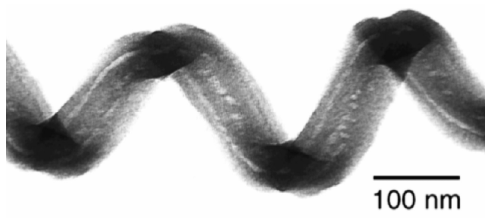
Figure 4. TEM micrograph of a single helical carbon tubule nanocoils [6]. Reprinted with permission from [6], Copyright 2000 Japan Society of Applied